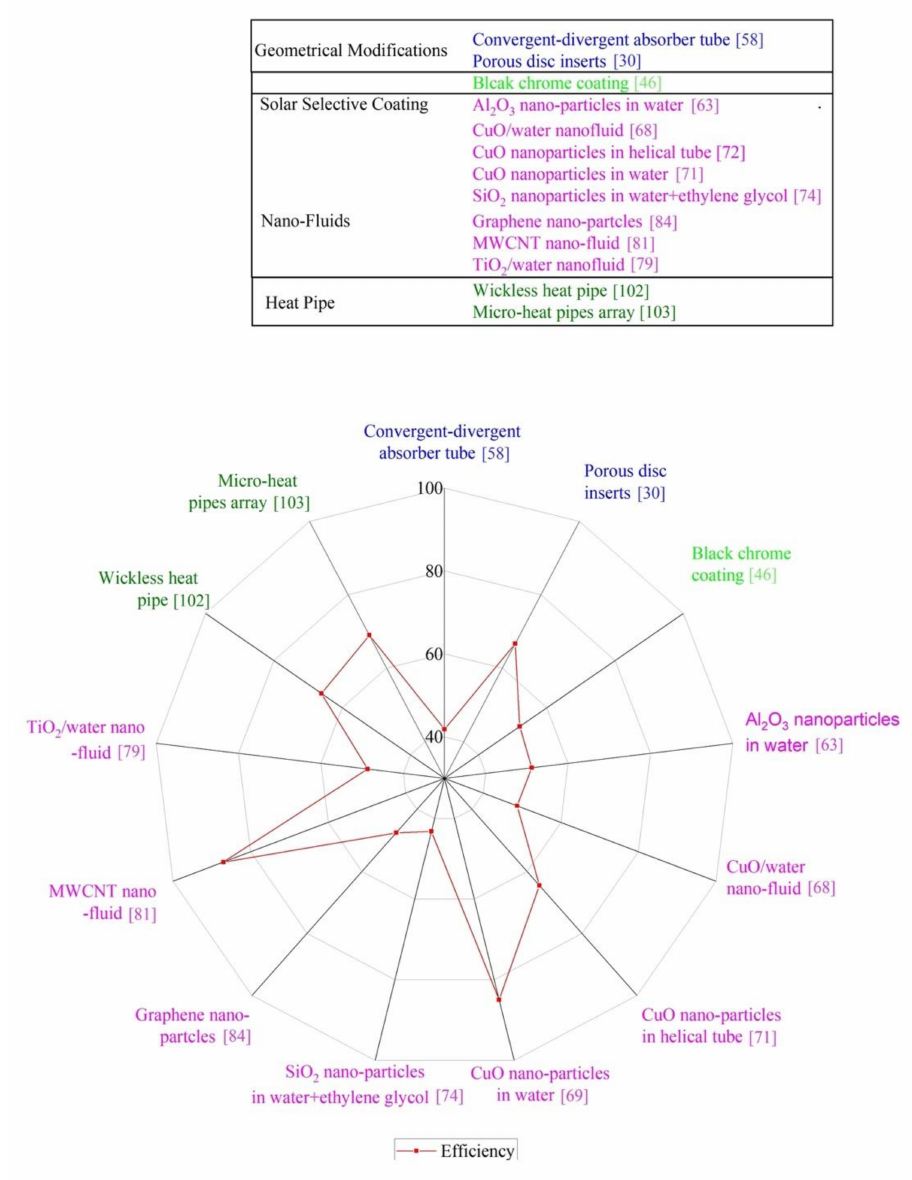
Figure 5. Comparison of efficiency exploiting different